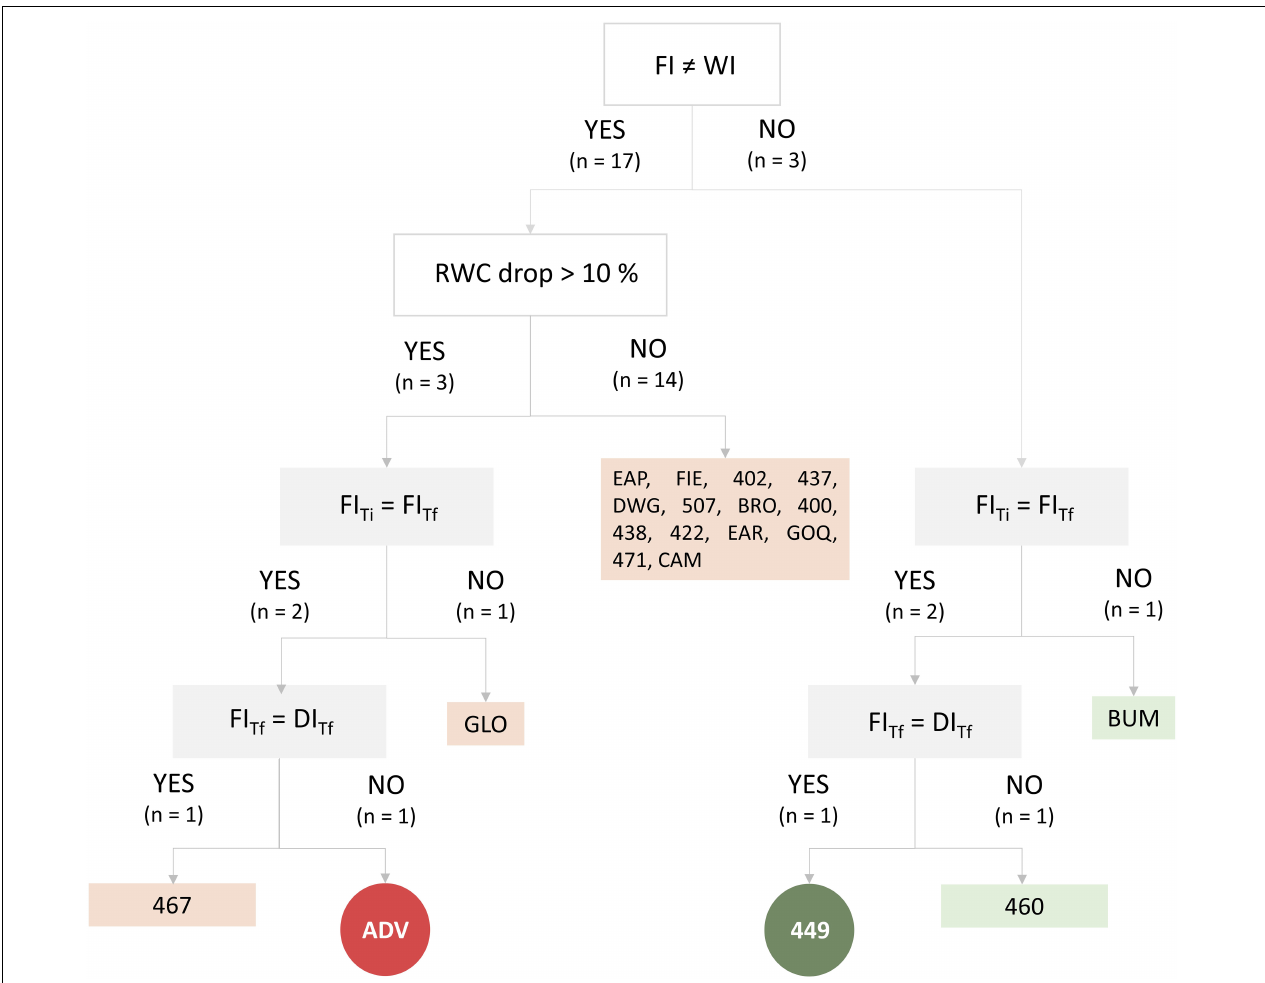
FIGURE 1 | Classification tree (Rokach and Oded, 2015; Xue et al., 2015) based on plant physiological parameters to evaluate which cultivars were more tolerant and susceptible to deficit irrigation. White boxes represent conditionals evaluated in the second selection assay (RWC drop > 10%); gray boxes represent conditionals evaluated in the third selection assay (RWC, Pn, and (cid:57) stem ). Edges represent the answers (yes or no) to the conditionals. Conditional output codes correspond to IDs of cultivars ( Supplementary Table 1 ). Light green (boxes) conditional outputs represent tolerant cultivars; pink (boxes) conditional outputs represent susceptible cultivars. Circular dark green conditional output (449) represents the most tolerant cultivar; circular dark red conditional output (ADV) represents the most susceptible cultivar. FI, full irrigation treatment; WI, withholding irrigation treatment; DI, deficit irrigation treatment. Ti and Tf represent the initial and final times of the assay. RWC, relative water